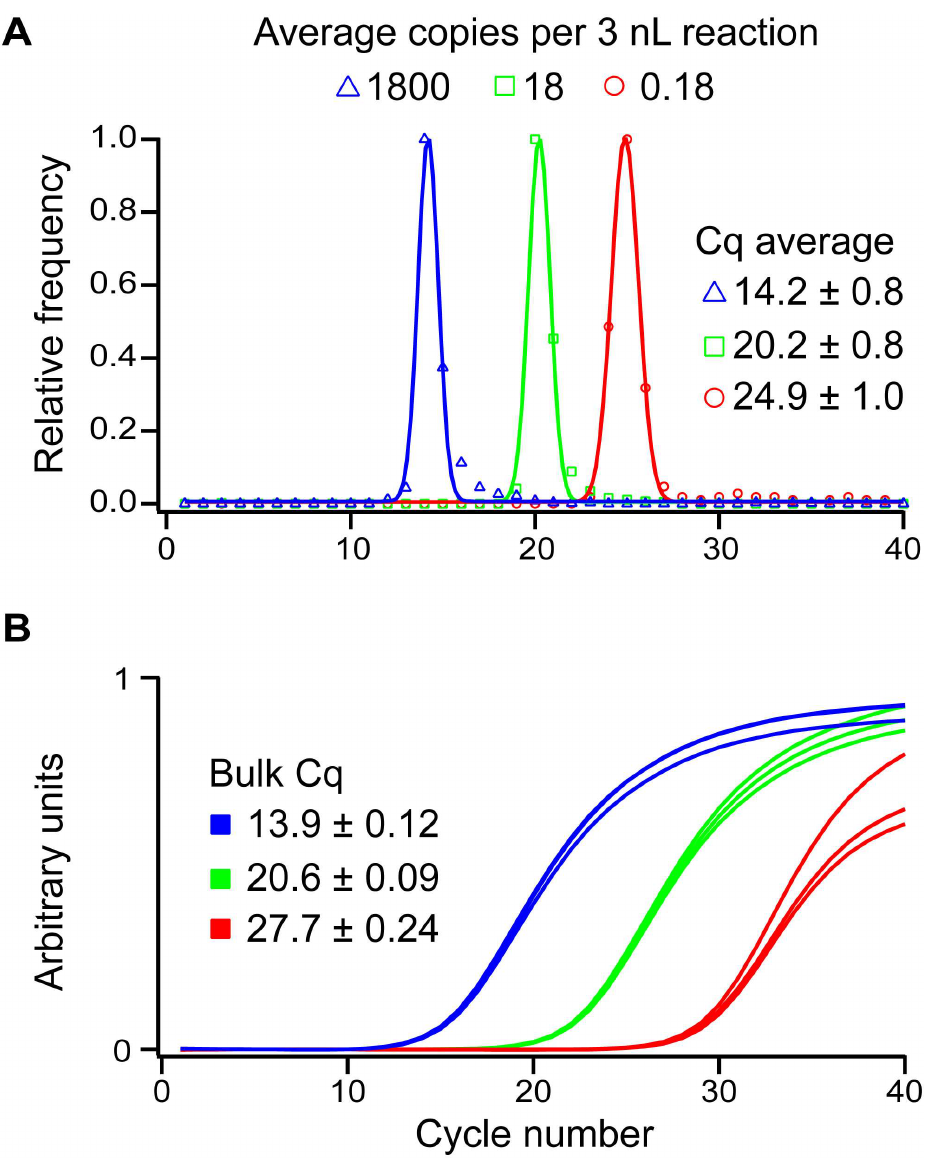
Fig 6. Comparison of digital (A) and bulk (B) results of real-time reversetranscription PCR experiments of HCV RNA at three different concentrations. Digital and bulk experiments were run at the same three concentrations (each separated by a 100x difference). The exposure time used in the experiment was 20 s. In (A), symbols show a histogram of the relative frequency of Cq values obtained in the experiment for the denotedconcentration; solid lines depict the Gaussian fit for each concentration. Points denote the calculated histogram of Cq values at each concentration. Average Cq values are the maximum of the Gaussian fit and the errors are the full width at half maximum value of the Gaussian fit. (B) Bulk traces of reverse transcription PCR of HCV RNA. Average Cq values are shown; error denotes S.D. among the replicates(N =